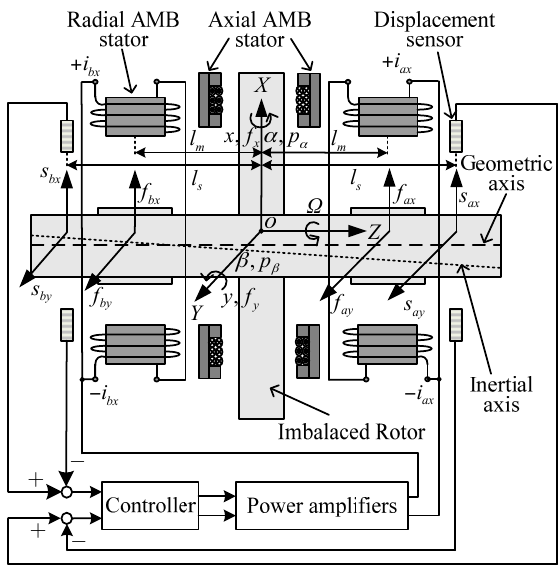
Figure 1. Diagram of the AMB system in the XZ plane.